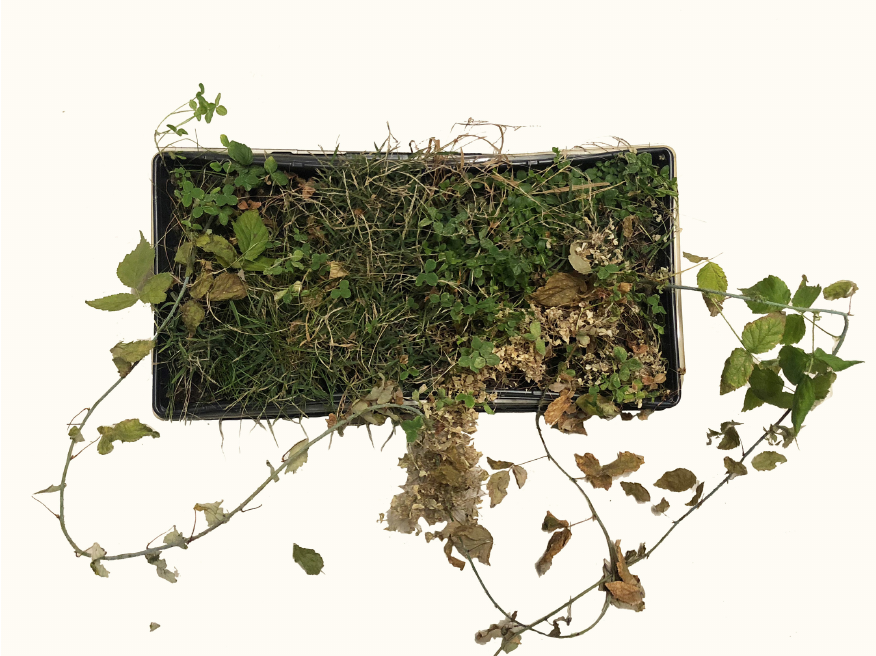
Figure 15: Indoor soil seed bank test planter, plot #4 (Nason Hall at Rensselaer Polytechnic Institute), including eight species: smooth crabgrass ( Digitaria ischaemum ), white clover ( Trifolium repens ), prostrate knotweed ( Persicaria sp.), chickweed ( Stellaria sp.), raspberry ( Rubus sp.), broadleaf plantain ( Plantago major ), wood sorrel ( Oxalis sp.), and fleabane ( Erigeron